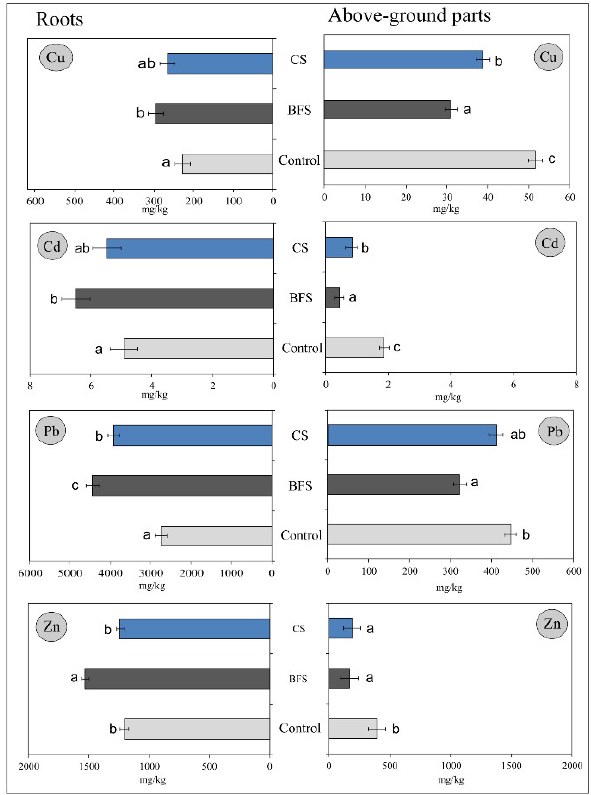
Figure 3. Effect of BFS and CS on Cu, Cd, Pb, and Zn accumulation in the above-ground parts and roots of Dactylis glomerata L.